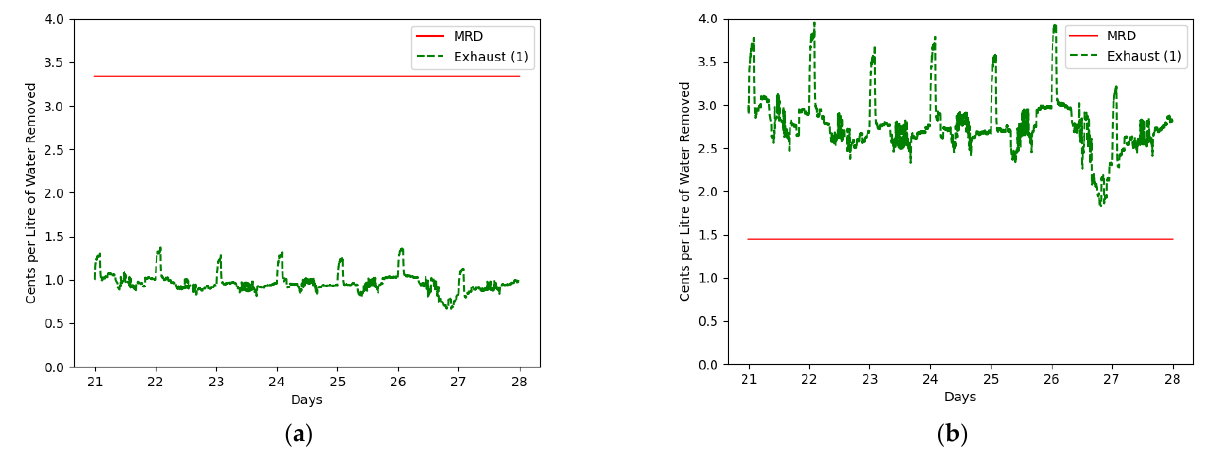
Figure 5. MRD and exhaust fan cost comparison in winter (21 – 28 December) assuming energy costs of ( a ) $4.80/GJ for gas, $0.127 $/kWh for electricity, and ( b ) $14.00/GJ for gas, $0.055 $/kWh for elec- tricity. Table 8. Comparison between experimental data and simulation results for MRD spring test